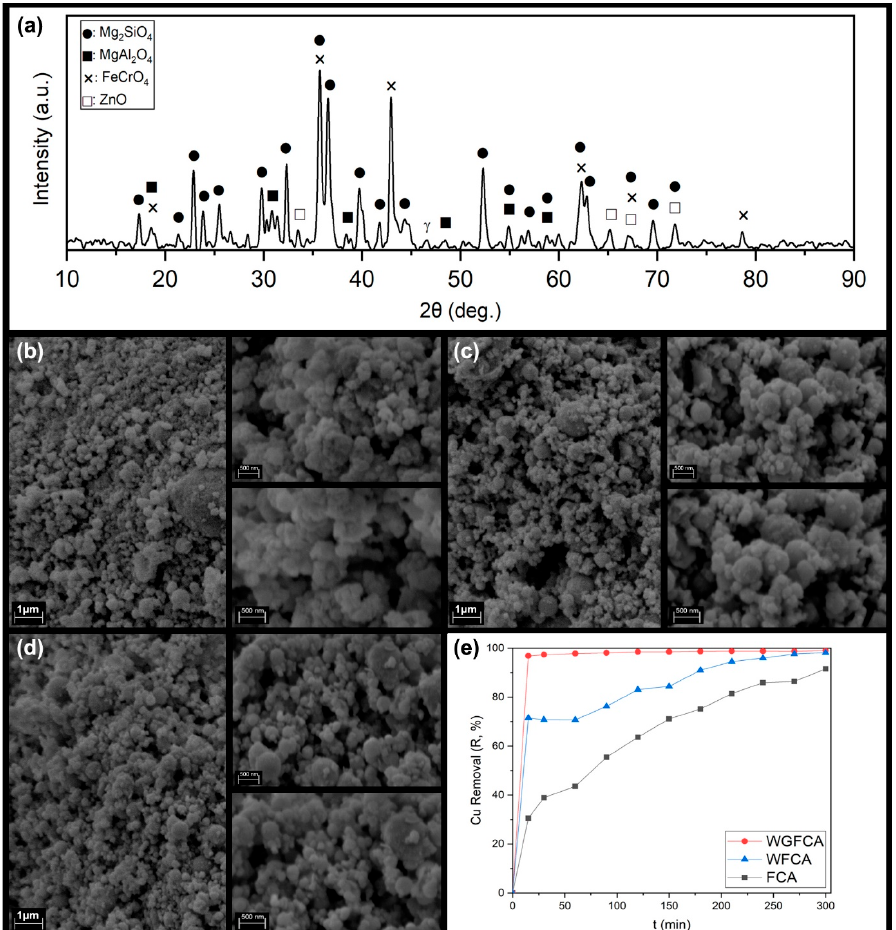
Figure 1. ( a ) XRD spectrum of the FCA; SEM images of ( b ) FCA, ( c ) WFCA, ( d ) WGFCA with ×20k, ×60k, and ×75k magnifications, and ( e ) R% values of the untreated and treated samples.